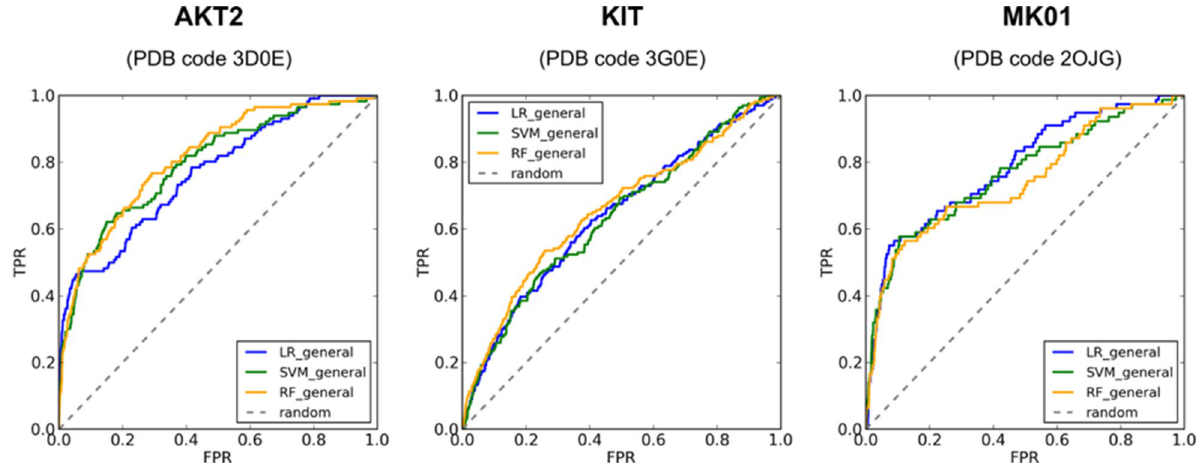
Figure 9. AUC ROC curves for the general scoring functions trained with MLR, SMOreg and RF evaluated on the AKT2, KIT and MK01 kinase datasets from